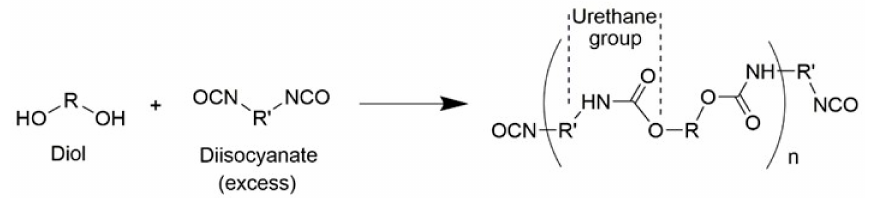
Figure 2. Schematic diagram of the PU synthesis